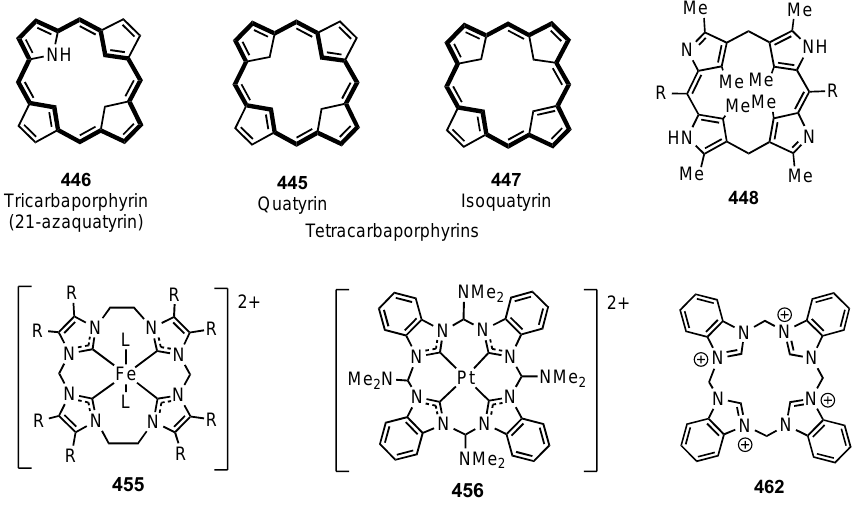
Figure 11. Tri- and tetracarbaporphyrinoids.